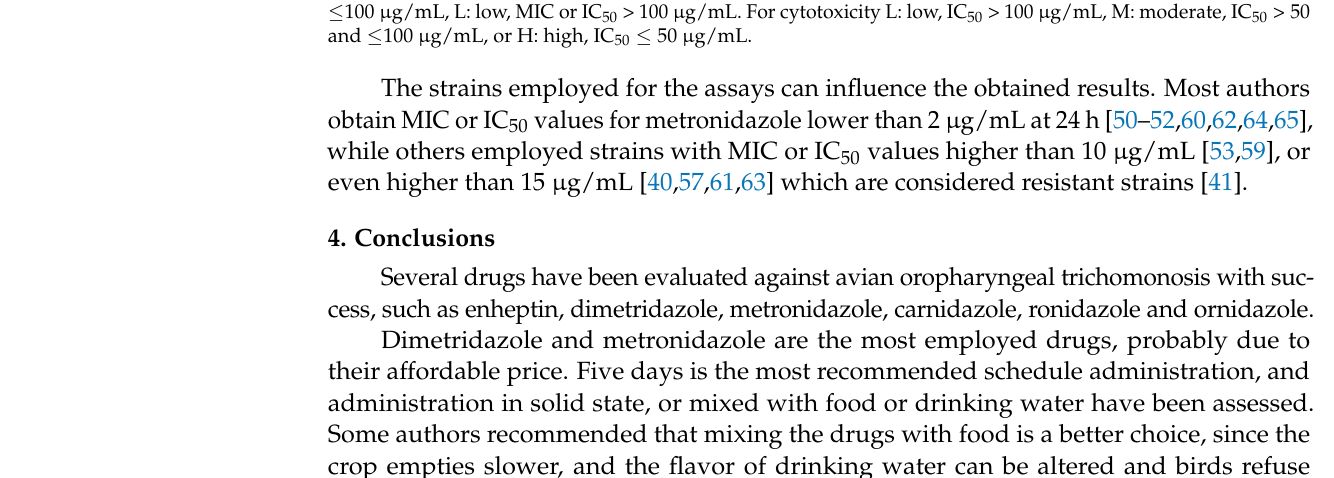
Table S2: T. gallinae resistance; Table S3: MLC values (resistance); Table S4: Novel treatment and delivery systems; Table S5: Plant natural